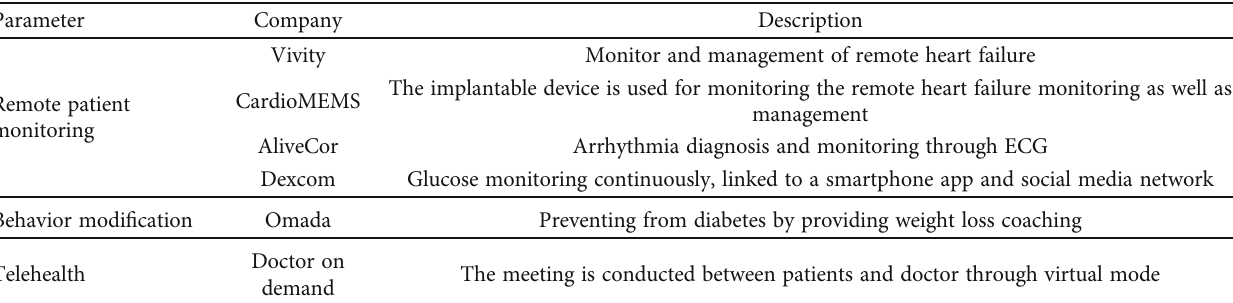
Table 2: Healthcare case studies with the